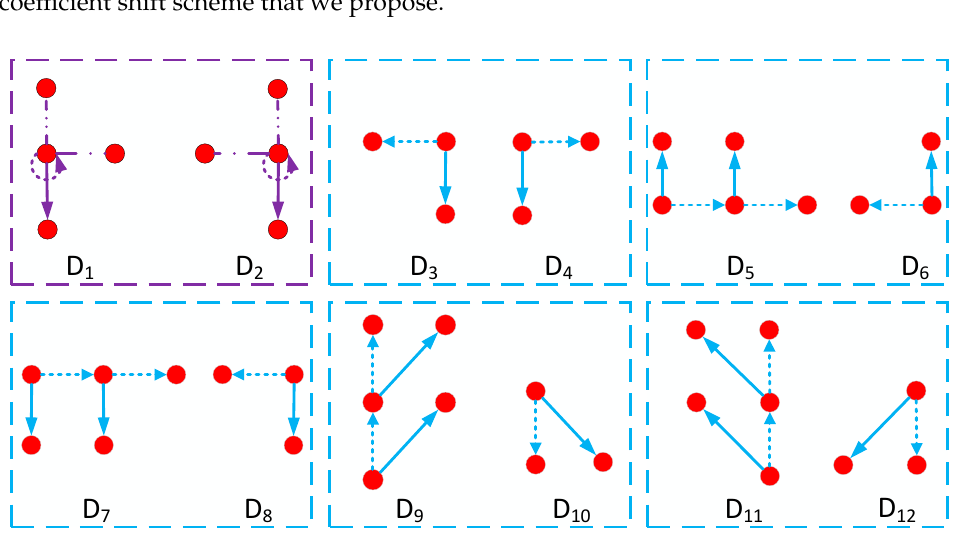
Figure 3. Coefficient shift strategy for D 1 ~ D 12 set. If the coefficient pairs ( 𝑈 (cid:3045)(cid:2869) , 𝑈 (cid:3045)(cid:2870) ) belong to 𝐷 (cid:2869)(cid:2871) , 𝐷 (cid:2869)(cid:2872) , 𝐷 (cid:2869)(cid:2873) , 𝐷 (cid:2869)(cid:2874) , 𝐷 (cid:2869)(cid:2875) , 𝐷 (cid:2869)(cid:2876) , we only used the coefficients of these sets in this scheme for shifting, not for embedding the data.